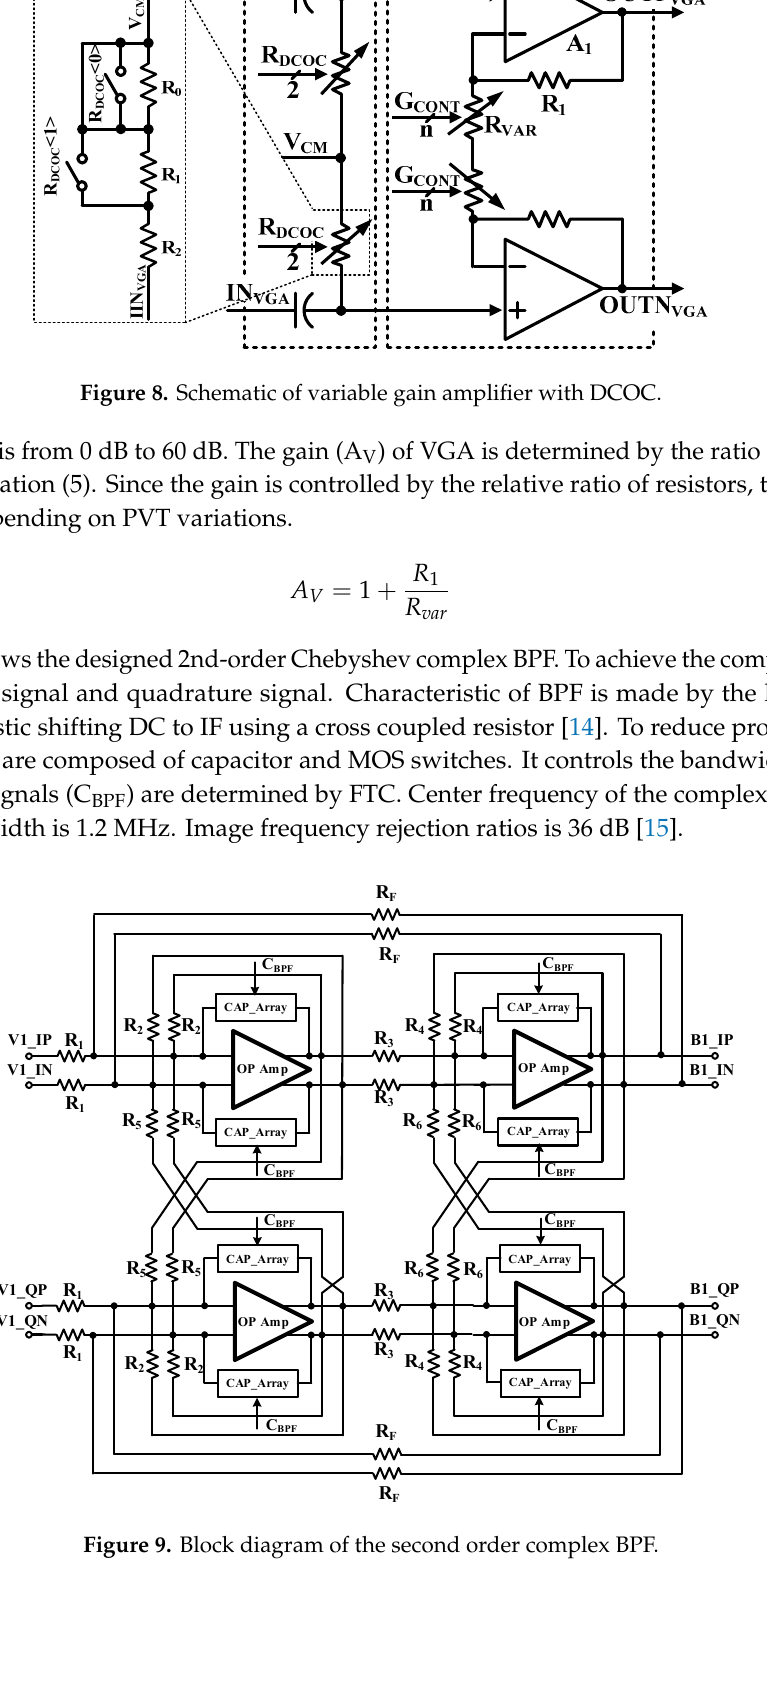
Figure 7. Timing diagram of the DCOC Controller. As shown in Figure 8, the pseudo differential structure is used for the VGAs for infinite input